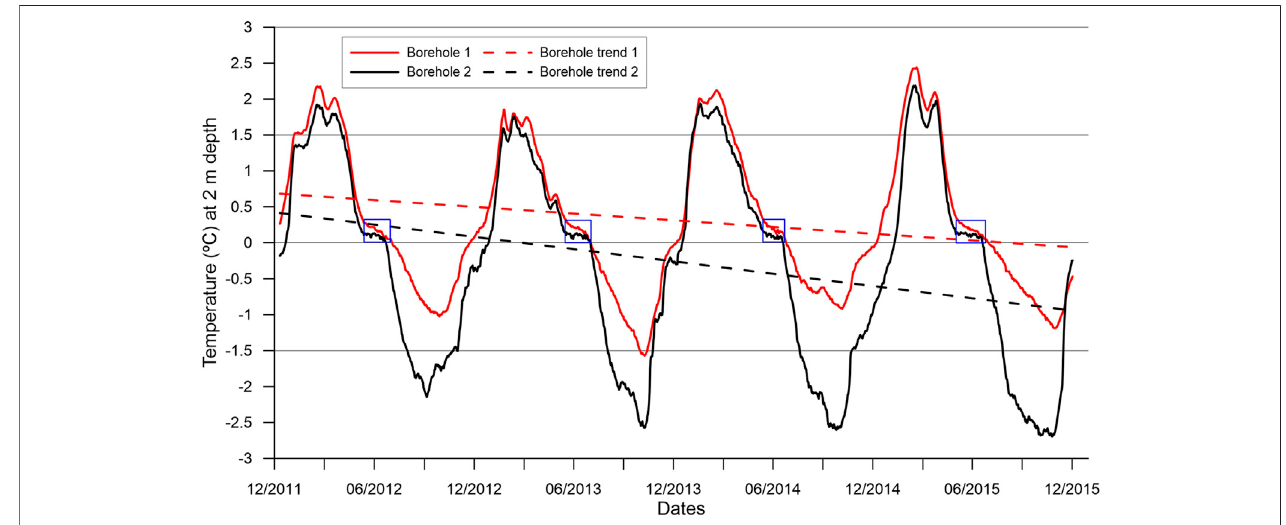
FIGURE10| Activelayertemperaturerecords(dailyaverages)atthetwoshallowboreholes(2 mdepth)atTapado1rockglacier(see Figure1 )betweenNovember 2011 and November 2015. Blue boxes indicate the zero-curtain periods during freezing conditions (May-June).